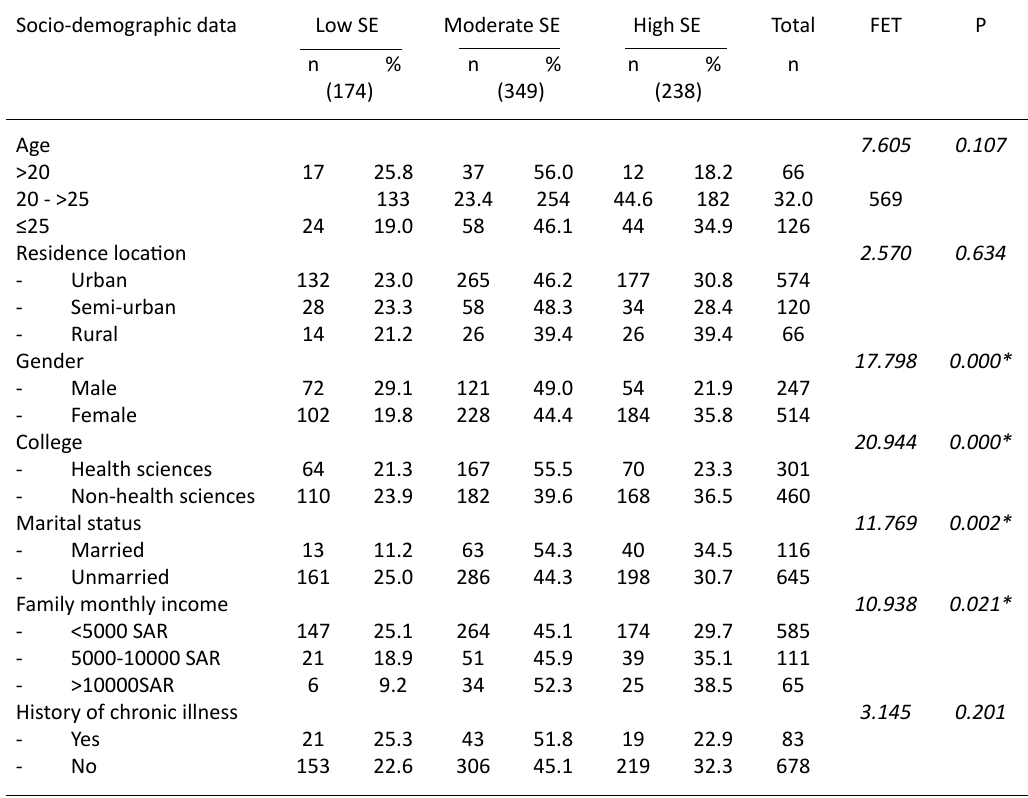
Table 3. Relationship between students' total SE for COVID-19 pandemic and their demographic variables (n= 761) Socio-demographic